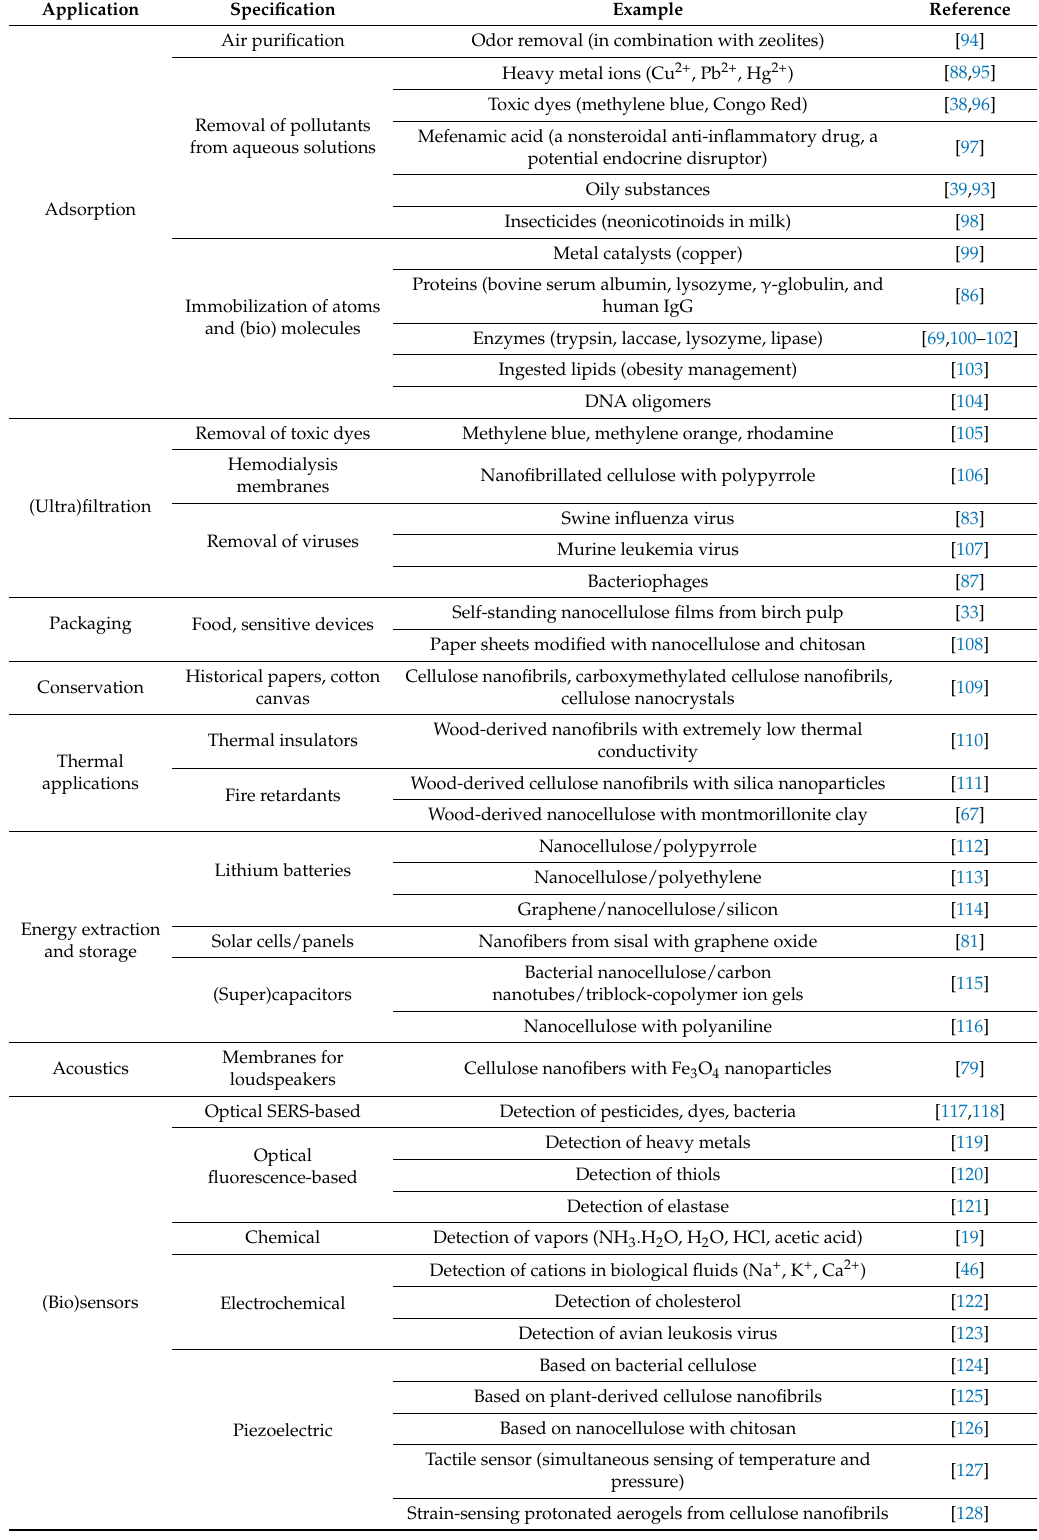
Table 2. Industrial and (bio)technological applications of